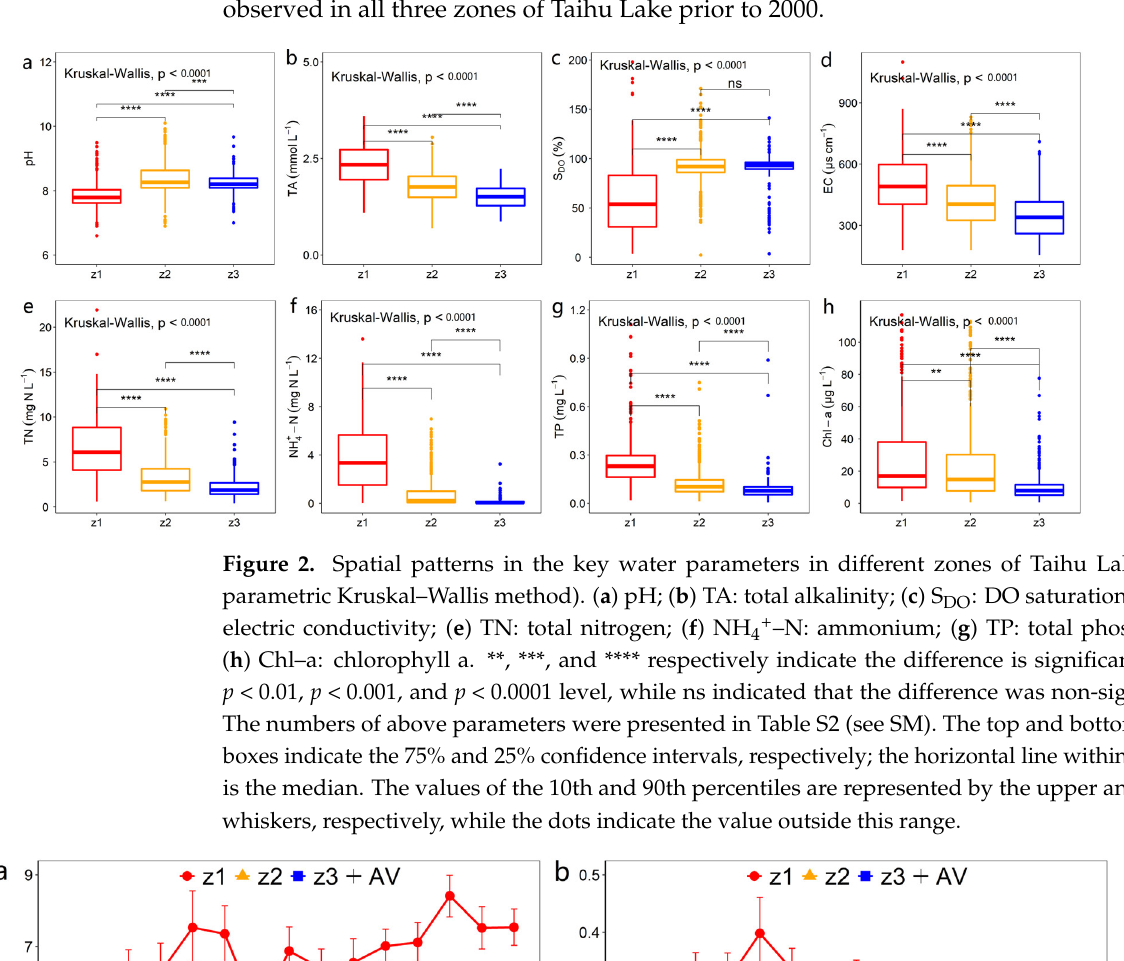
spectively, while the dots indicate the value outside this range.